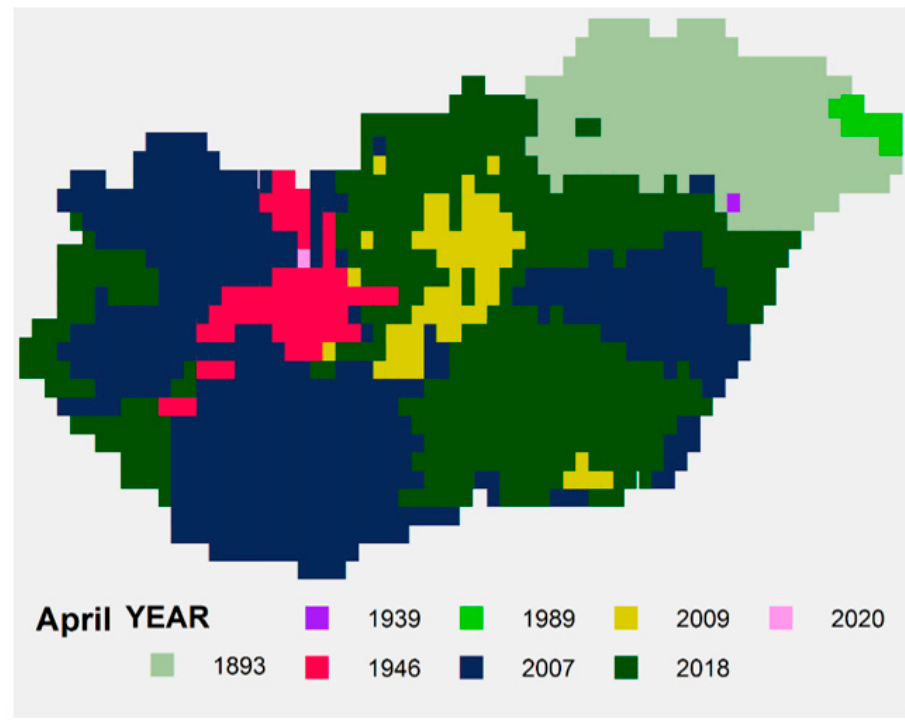
Figure A5. April: Year of maximum SPTI values, 1871–2020.